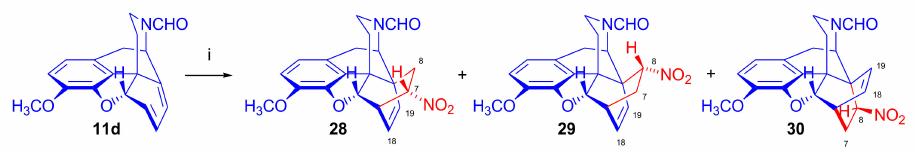
Figure 11. Reaction of N 17 -formyl-6-demethoxynorthebaine with nitroethene. Reagents and conditions : (i): nitroethene, benzene, reflux, 50 h.